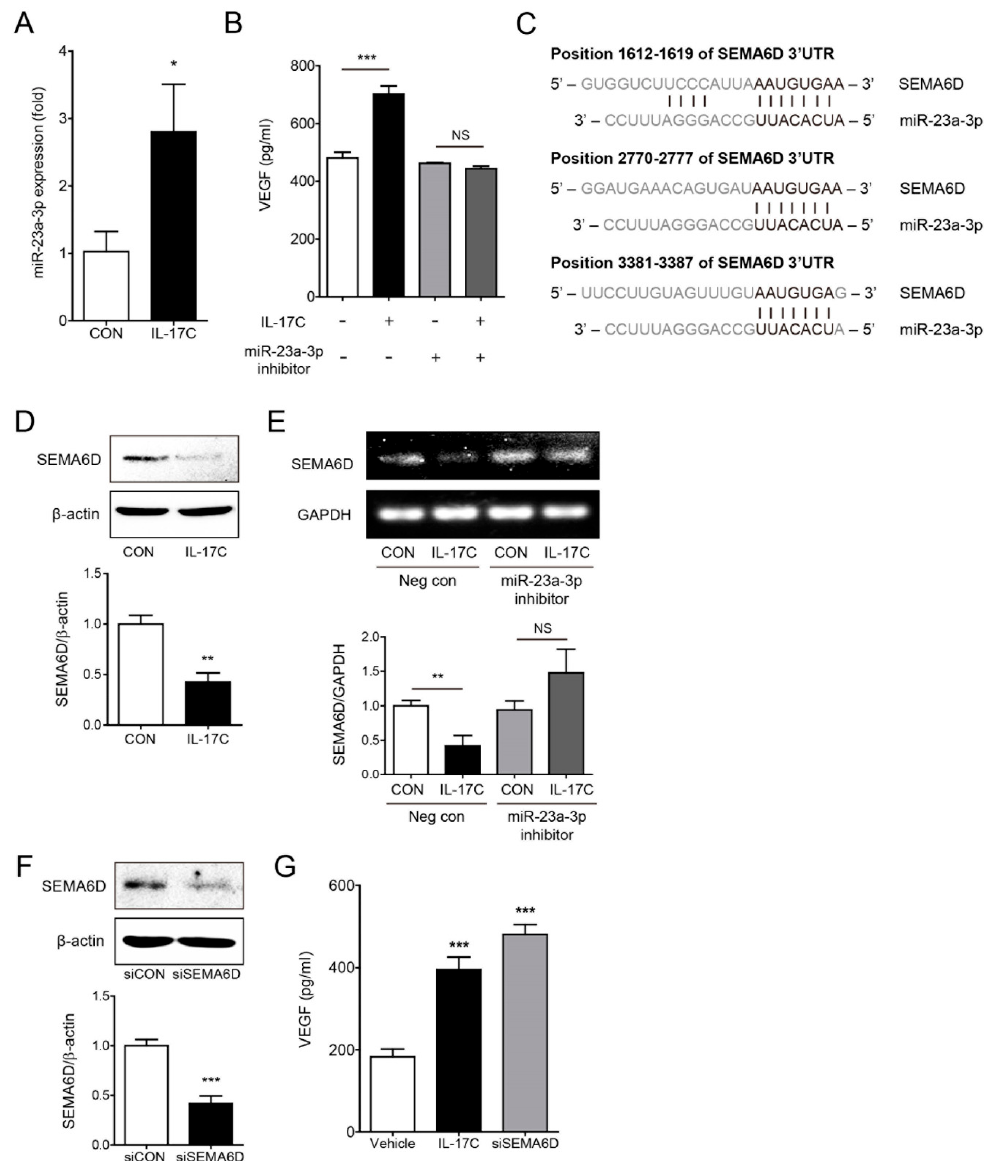
Figure 5. IL-17C-induced miR-23a-3p expression mediates VEGF secretion by targeting SEMA6D. ( A ) The expression of miR-23a-3p is higher in IL-17C (100 ng / mL, 3 h)-treated DLD-1 cells. Error bars, SD ( n = 3). * p < 0.05 vs. the control group. ( B ) ELISA was used to determine the level of IL-17C-induced VEGF concentration in miR-23a-3p inhibitor-transfected DLD-1 cells. Error bars, SD ( n = 4). *** p < 0.001; NS, not significant. ( C ) Target gene prediction was analyzed by two independent miRNA target databases. There are sequences of three predicted binding positions (black letter) of miR-23a-3p within 3 (cid:48) -UTR of SEMA6D mRNA. ( D ) Representative bands of Western blotting and quantitative analyses of SEMA6D protein expression in DLD-1 cells after IL-17C (100 ng / mL, 8 h) stimulation are shown. β -actin was used as a loading control. Error bars, SD ( n = 3). ** p < 0.01 vs. the control group. ( E ) RT-PCR was conducted for comparing the alteration of SEMA6D expression in miR-23a-3p inhibitor-transfected DLD-1 cells stimulated with IL-17C to that in the negative control DLD-1 cells. GAPDH was used as a loading control. The bar graph below shows the result of quantitative analyses. Error bars, SD ( n = 3). ** p < 0.01; NS, not significant. ( F ) Representative bands of Western blotting and quantitative analyses of SEMA6D protein expression after siSEMA6D transfection are shown. Error bars, SD ( n = 3). *** p < 0.001 vs. the siCON group. ( G ) Secreted human VEGF levels in siSEMA6D-transfected DLD-1 cells were analyzed using ELISA. Error bars, SD ( n = 4). *** p < 0.001 vs. the control